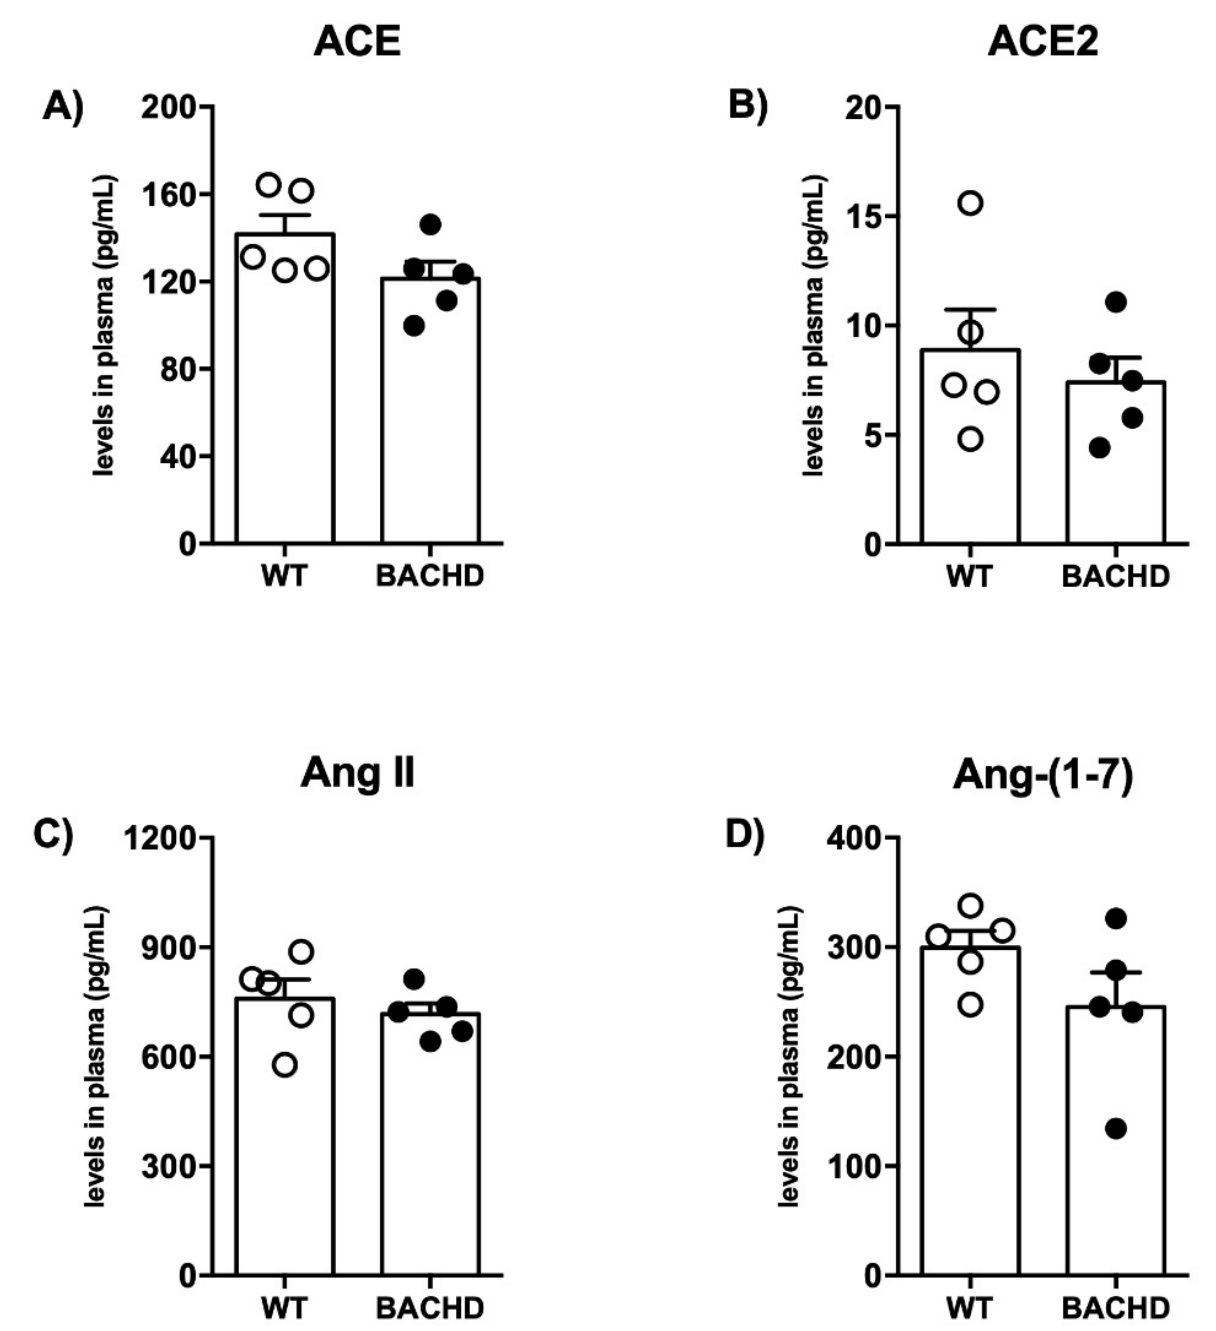
Figure 2. RAS components’ levels in the plasma of BACHD and WT mice. ( A ) ACE, ( B ) ACE2, ( C ) Ang II, and ( D ) Ang-(1-7) plasma levels are not altered in 24-month-old BACHD mice. Results are expressed as mean ± SEM. n = 5. * p < 0.05 compared with WT group. The data were analyzed by Student’s t -test.